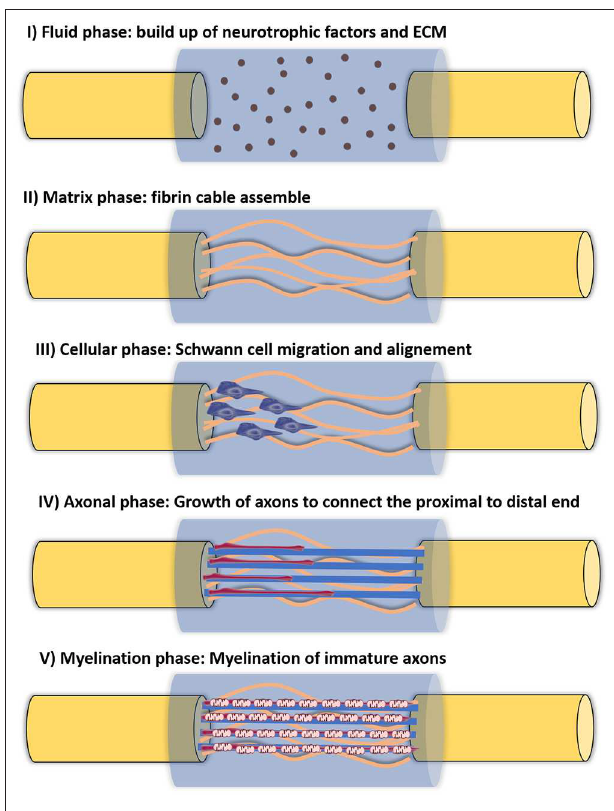
FIGURE 4 | Five different phases of nerve regeneration inside a hollow NGC. The phase corresponds to the sequenced phases of Wallerian degeneration and resulting regeneration mechanism. Phase I corresponds to the fluid phase, where the conduit is filled with plasma exudate containing neurotrophic factors and ECM molecules. This phase takes place a few hours after injury. Phase II corresponds to the matrix formation, where fibrin cables are formed along the gap around 1 week after injury. Phase III is the cellular phase, where Schwann cells invade the gap, migrate and proliferate. They tend to align along the fibrin cable, forming the Bands of Bungner. Phase IV is axonal phase, which occurs around 2 weeks after injury. The re-growing immature axons use the biological cues provided by Schwann cells to reach their distal targets. Phase V corresponds to the myelin phase. At this time, around 3 weeks post-injury, Schwann cells shift to a myelinating phenotype and produce myelin which is wrapped around each axon, forming the mature myelinated